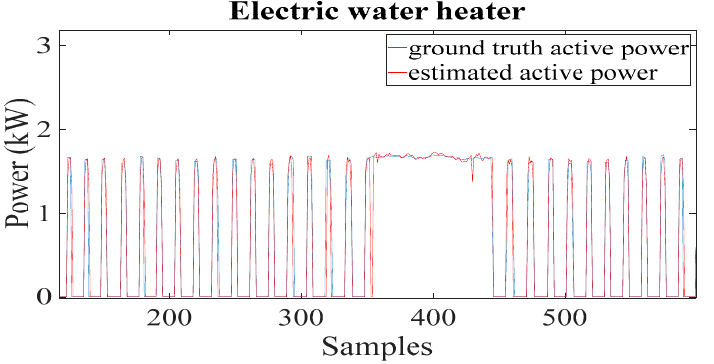
Figure 6. Electric water heater: blue, ground truth active power; red, estimated active power.